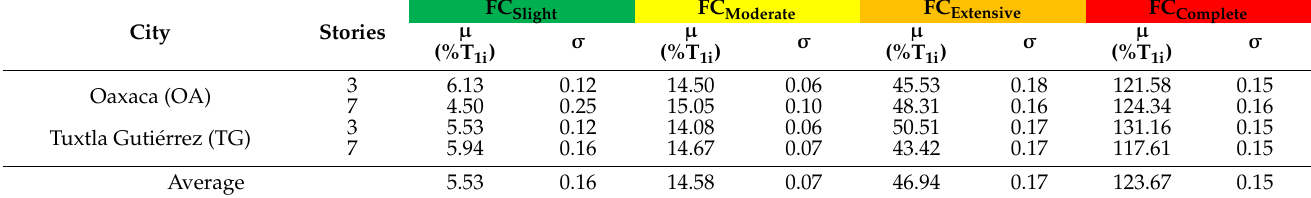
Table 10. The µ and σ of the fragility curves (FC) as a function of the %T 1i for the studied buildings.